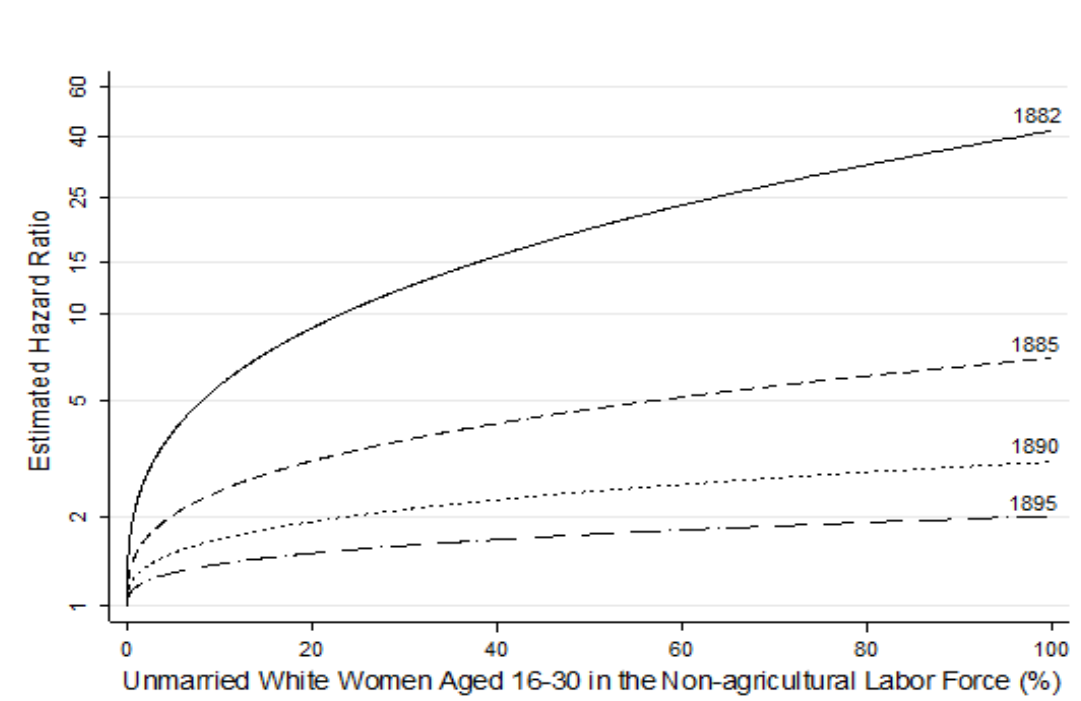
Figure 2: Estimated hazard ratios at different levels of family and gender role dissolution,